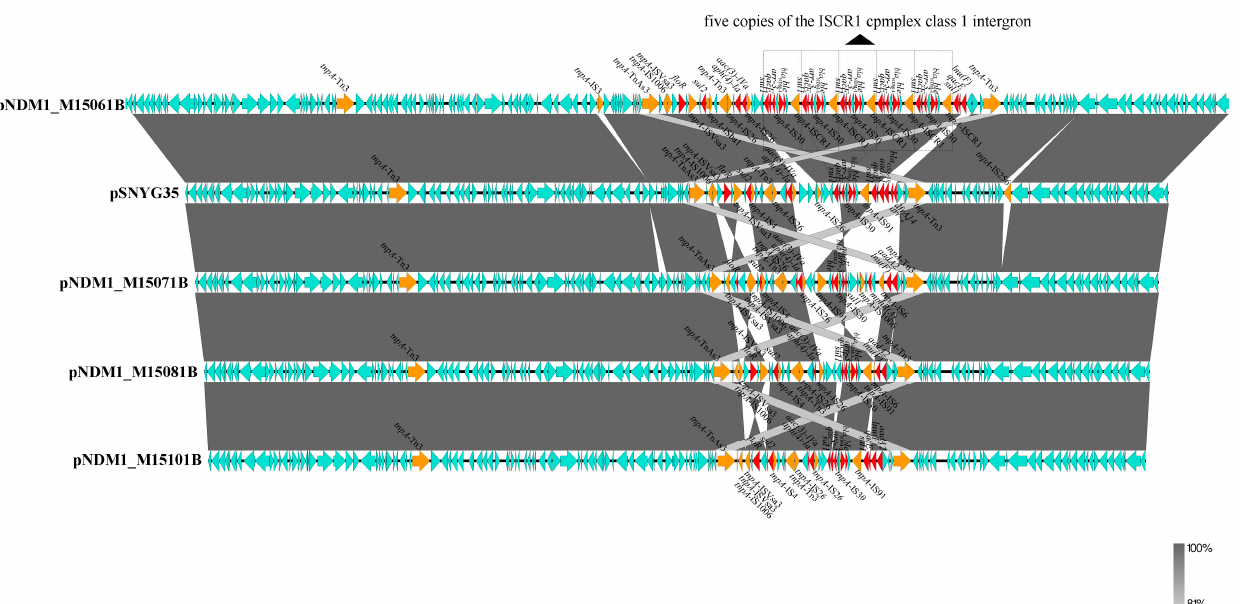
Figure 4. Linear alignment of bla NDM-1 -bearing untypable plasmids from P. mirabilis isolates by Easyfig. Arrows indicate the directions of gene transcription. Regions with 100% nucleotide sequence homology are shown in